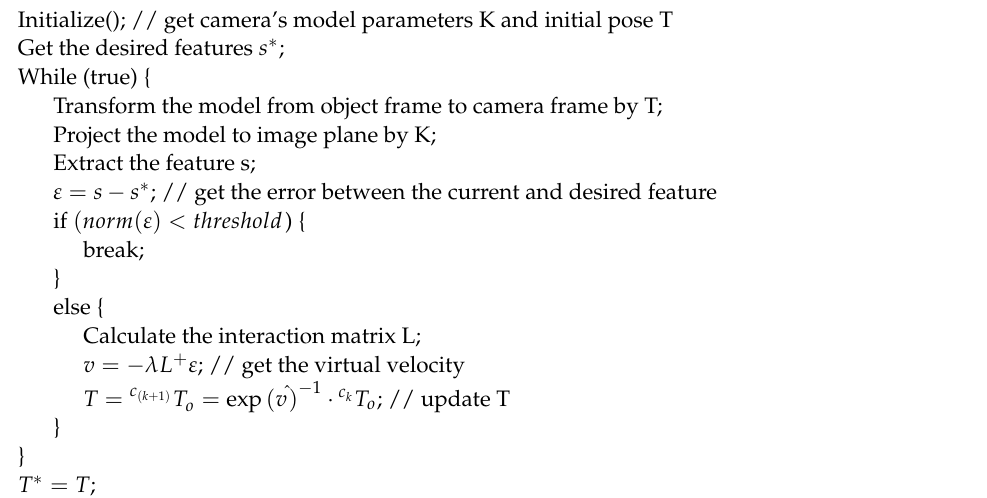
Algorithm 1 Pseudocode of the VVS